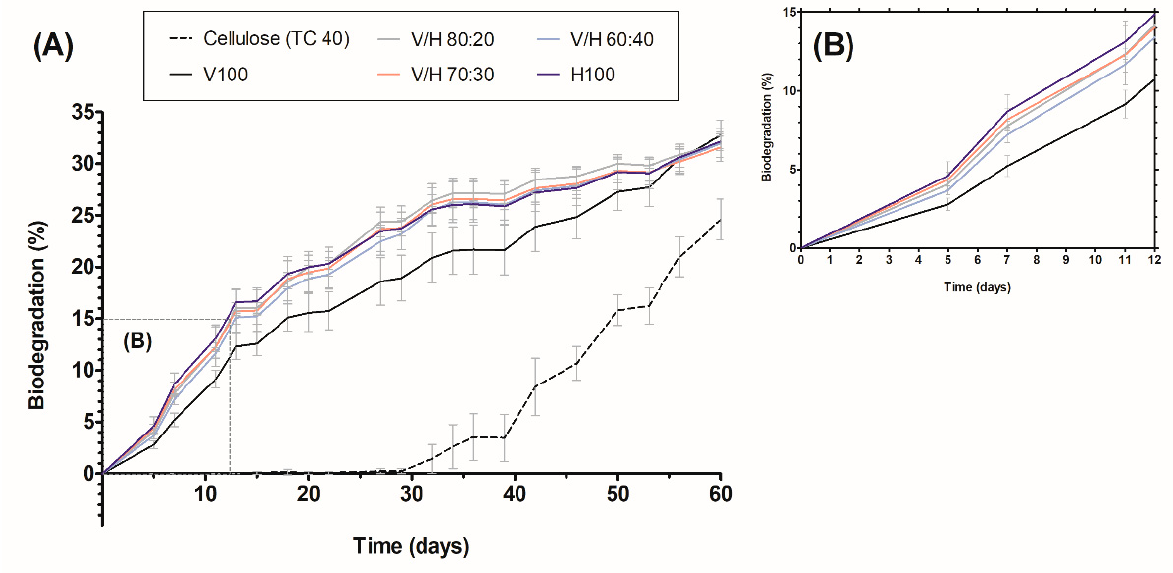
Figure 12. ( A ) Percentage of biodegradation over time of poly(3-hydroxybutyrate- co -3-valerate) (PHBV), poly(3-hydroxybutyrate- co -3-hydroxyhexanoate) (PHBH), their blends, and the reference (cellulose); ( B ) Detail of first 12 days of marine biodegradation.